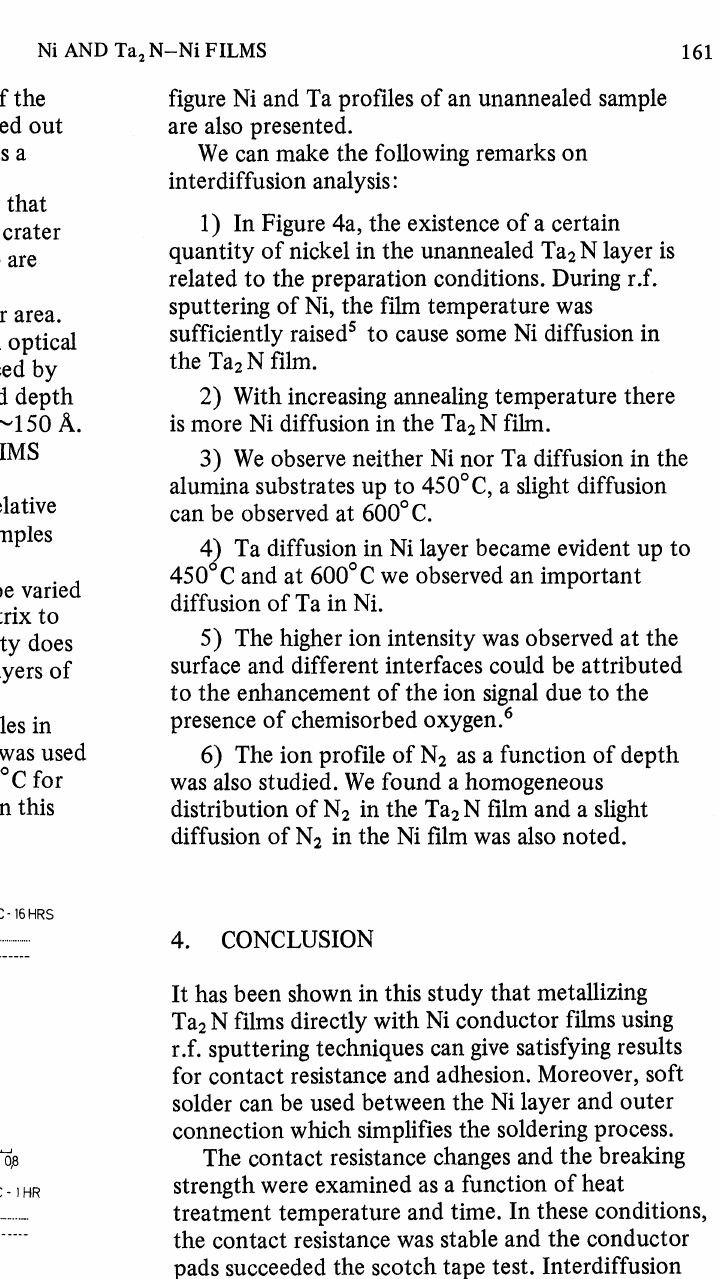
FIGURE 4 Ni and Ta profiles as a function of depth. (a) unannealed; (b) annealed at 250C, 16 h; (c) 450 C, h; (d) 600 C,